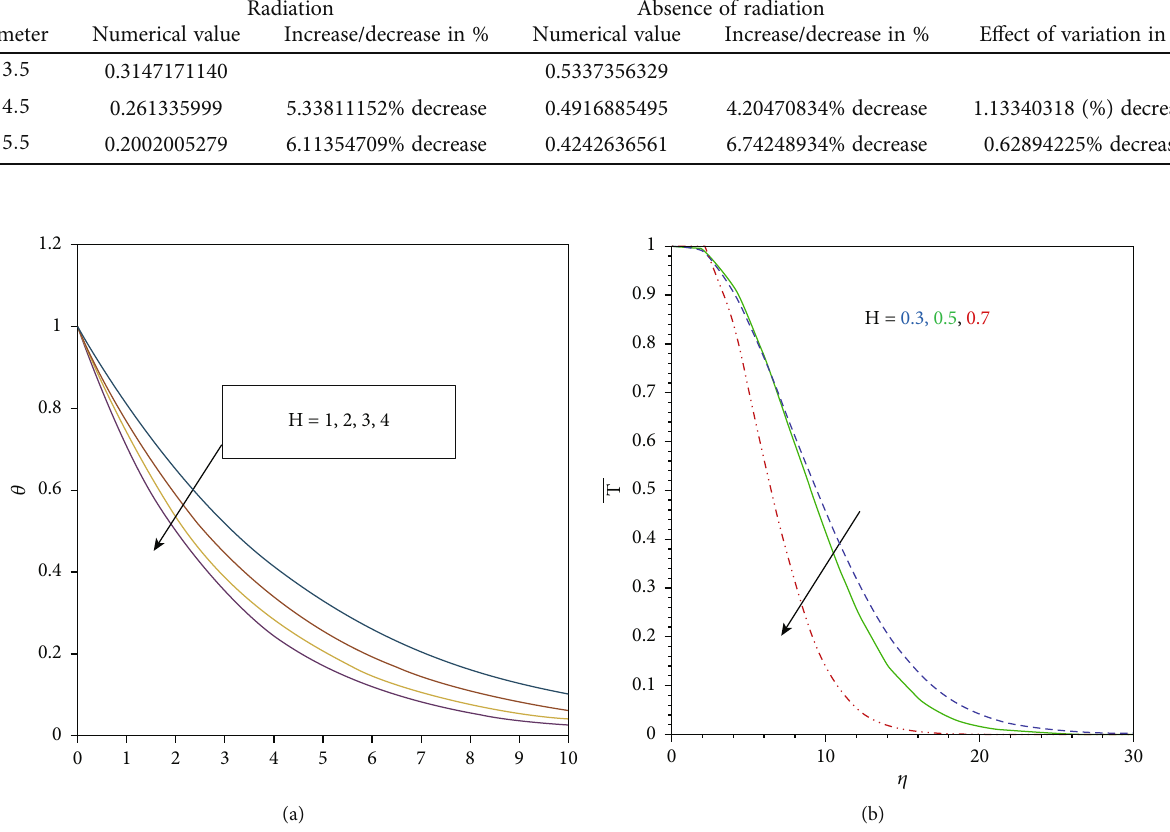
Figure 6: The e ff ects of heat generation on temperature pro fi les in (a) Deepthi et al. [29] and (b) the present